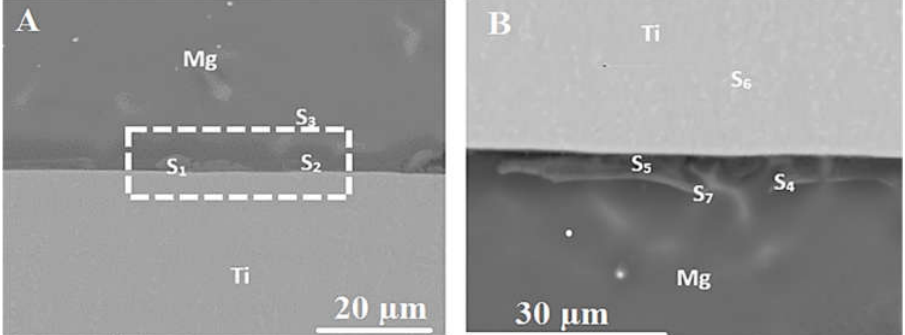
Figure 8. ( A ) Solid-state diffusion bonding of Ti and Mg for 60 min; ( B ) magnified region of the bond-line showing the reaction layer at the bond interface [23].